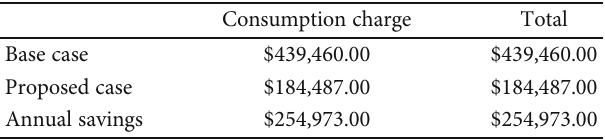
Figure 44: Monthly utility bills for the current and proposed systems for South Sudan. Table 19: Annual utility bills and savings by category (South